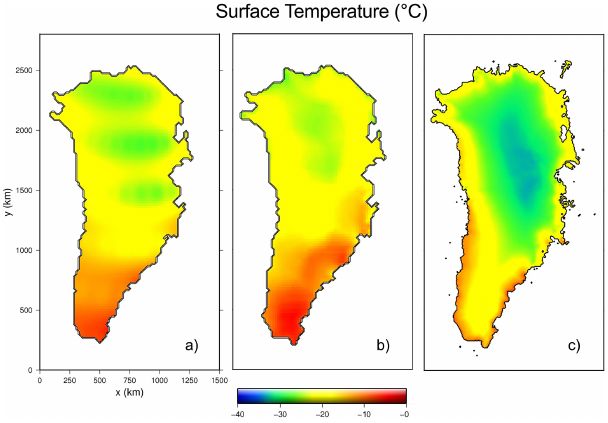
Figure 5. As Fig. 2, but for surface temperature. Please note that the colour scale for this plot is linear. Data base for (c) : Bamber et al. (2001a).